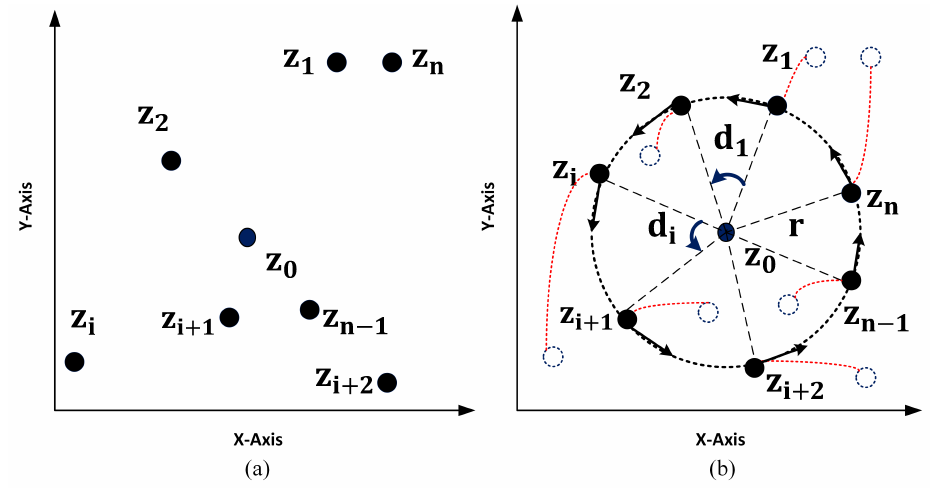
Figure 4. Circular formation with fixed target: ( a ) agents are initially positioned in the plane; ( b ) circular formation around fixed